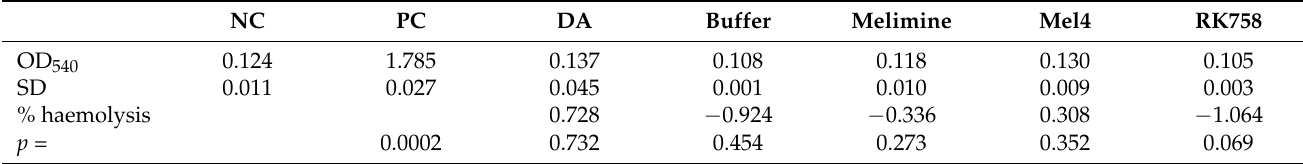
Table 2. Haemolytic activity of polydopamine–peptidomimetic-coated